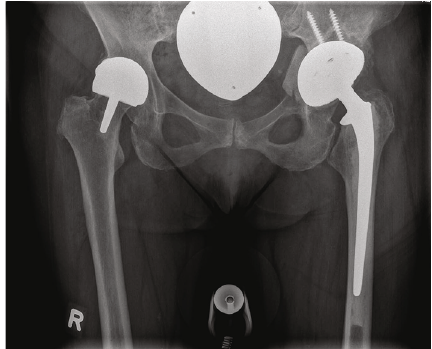
Figure 6: Follow-up X-ray 6 months after surgery. The anteroposterior view of the pelvis shows the correct placement of the implants and a boney healing of the Os